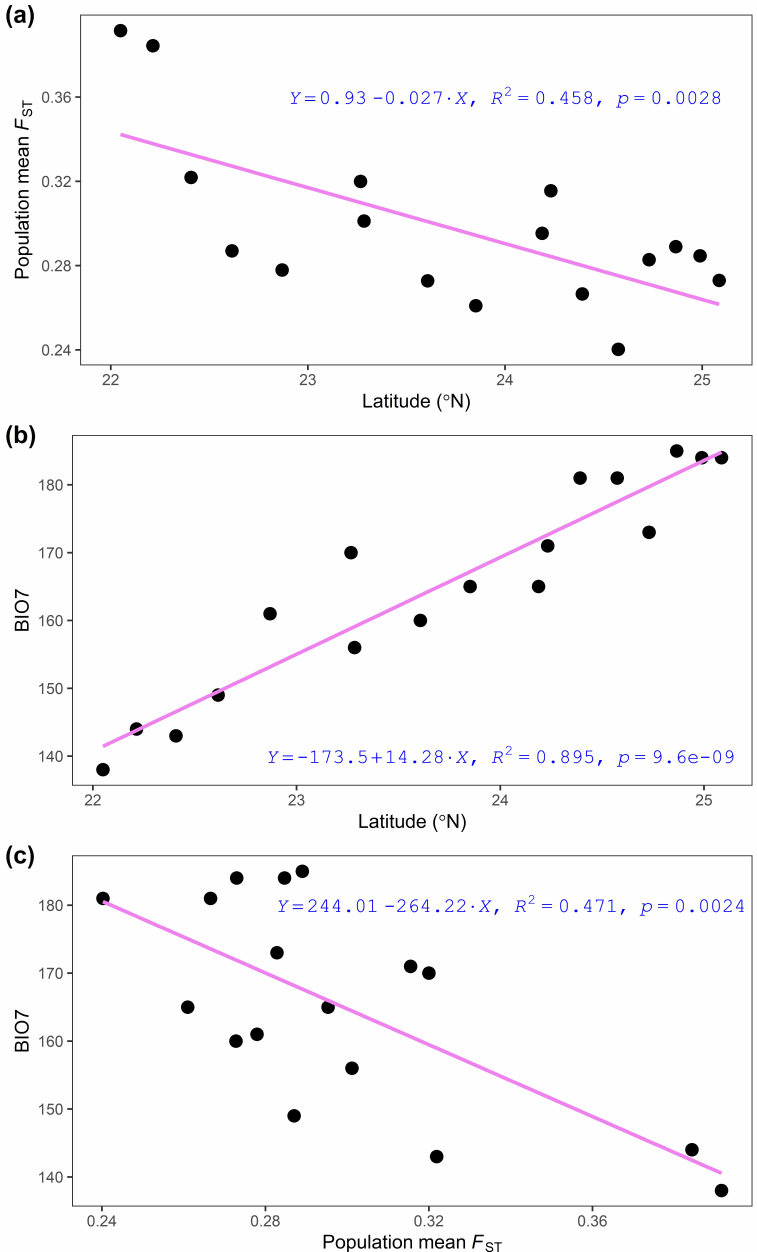
Figure 4. Regression plots showing the relationships between population mean F ST and latitude ( a ), between annual temperature range and latitude ( b ), and between annual mean temperature and population mean F ST ( c ). Pairwise population F ST was estimated using the total AFLP variation and used in calculation of population mean F ST (Table S6) BIO7, annual temperature